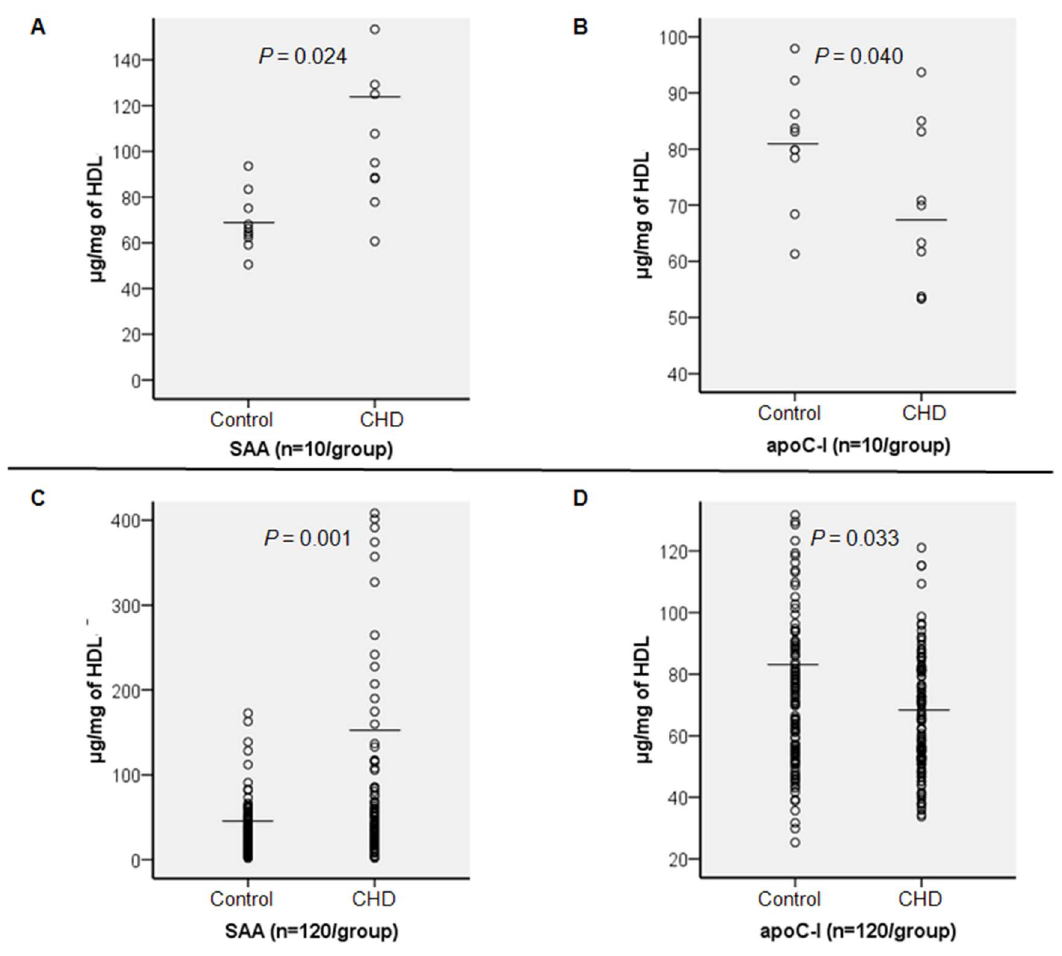
Figure 3. Quantified analysis of HDL-associated SAA and apoC-I. The concentration of SAA and apoC-I ( m g/mg of HDL) in HDL fractions of the discovery cohort (Figure A and B) and the validation cohort (Figure C and D) were measured using ELISA kits. The mean is indicated by the horizontal line. A: The mean of SAA is 126.5 6 67.3 (CHD group) vs. 68.7 6 12.4 (control group) P =0.024; B: The mean of apoC-I is 68.8 6 14.4 (CHD group) vs. 81.1 6 10.6 (control group) P =0.040; C: The mean of SAA is 154.9 6 303.6 (CHD group) vs. 48.6 6 154.5 (control group) P =0.001; D: The mean of apoC-I is 65.8 6 18.8 (CHD group) vs. 71.7 6 23.0 (control group) P =0.033.